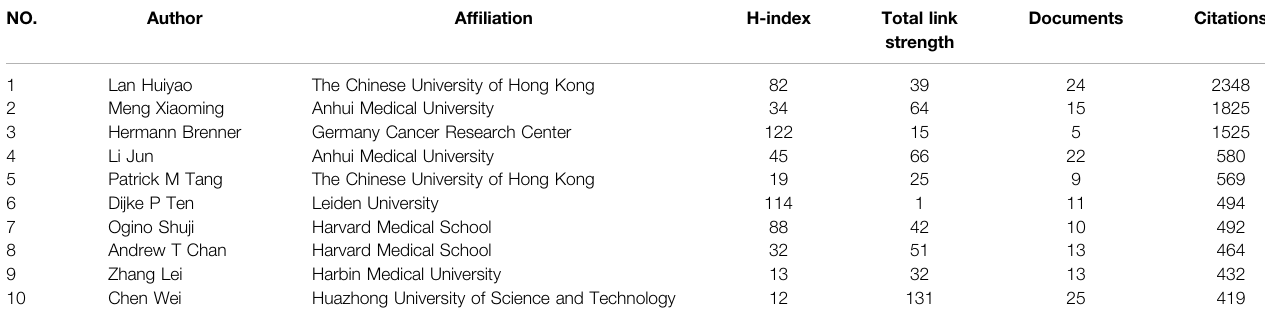
TABLE 4 | Pivotal authors of documents of SMAD7 in the fi eld of oncology from 2011 to 2020.